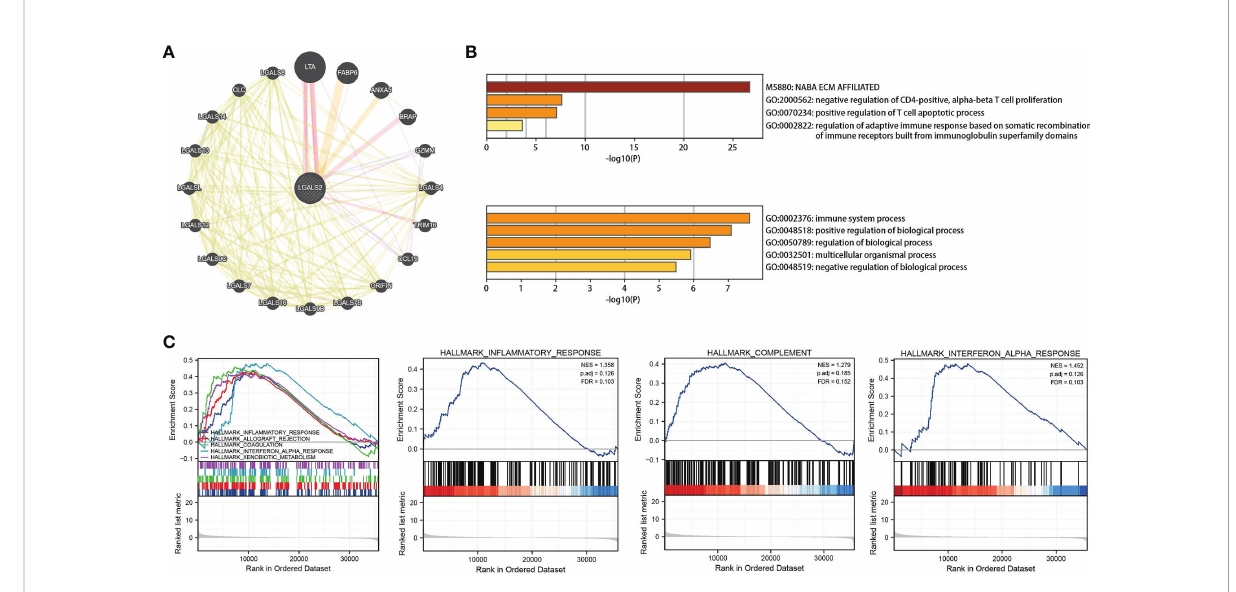
FIGURE 5 PPI network and functional enrichment analysis of LGALS2 . (A) PPI network of LGALS2 and its interacting proteins; (B) GO enrichment analysis of LGALS2 and its interacting proteins; (C) GSEA of the top 10 enriched pathways in DLBCL patients with high LGALS2